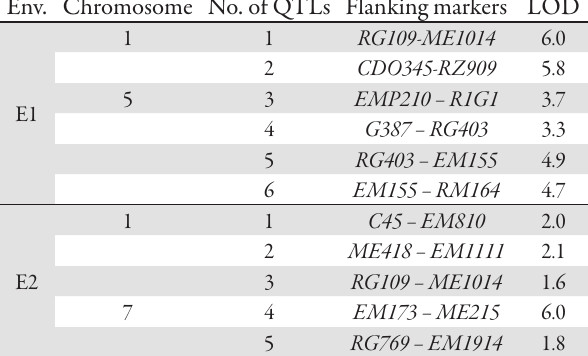
Tab.1. QTLs for grain yield detected under two water stress environments (E1 and E2) by multiple interval mapping (MIM) model in